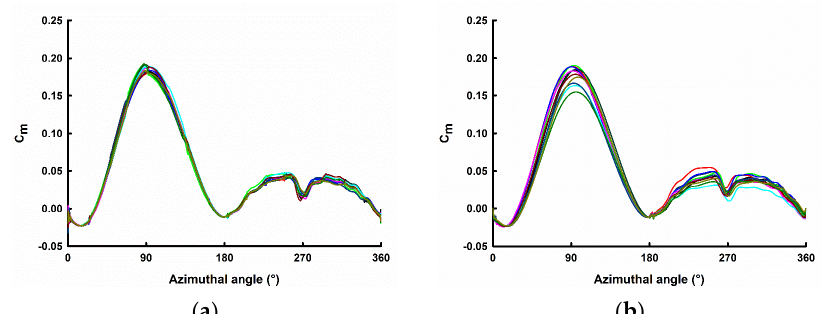
Figure 10. Coefficient of Moment (C m ) for various rotational cycles. ( a ) Randomisation Update Frequency = 45 time-steps; ( b ) Randomisation Update Frequency = 360 time-steps. Coefficient of Moment at various time instances (rotational cycles) are represented through different coloured lines. Due to randomized wind conditions, values vary every rotational cycle.